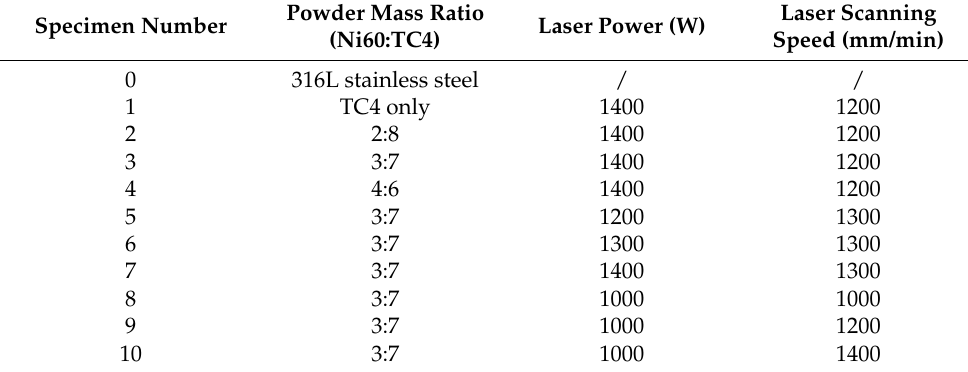
Table 3. Mass ratio of mixed powder and laser processing parameters.